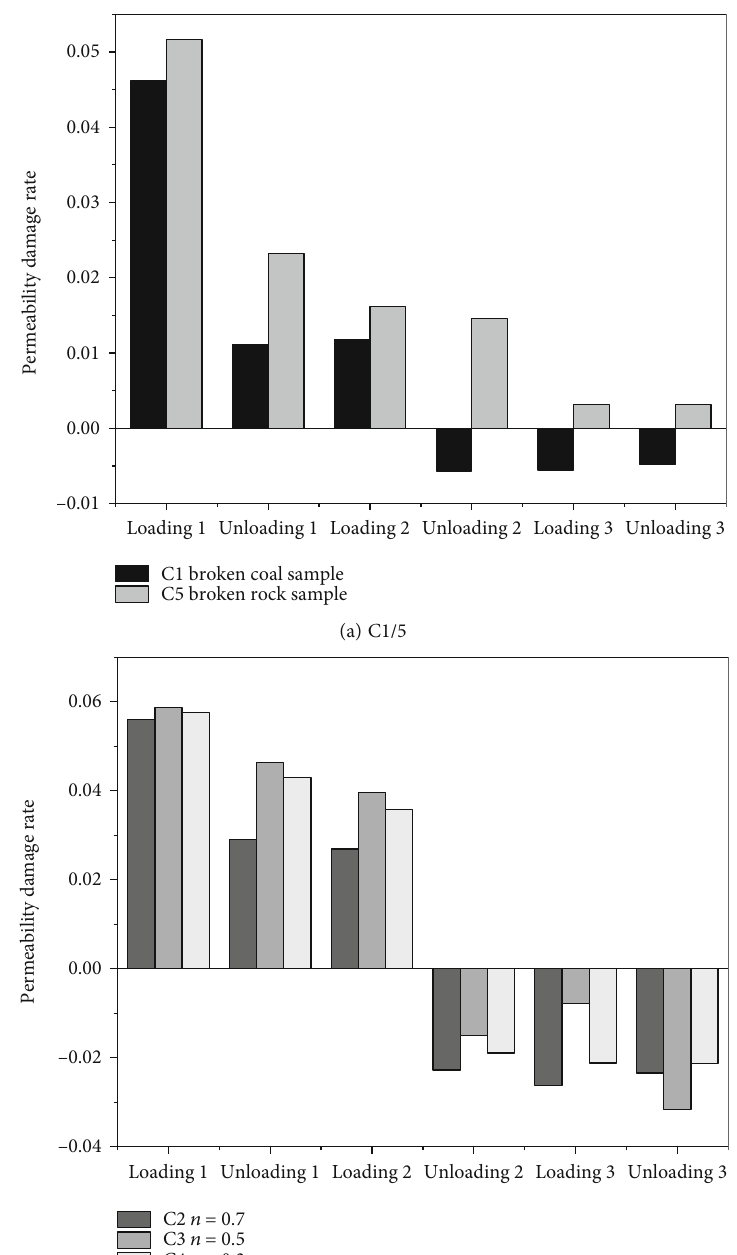
Figure 12: Rate of permeability loss in samples C1 ~ 5 under three loading and unloading